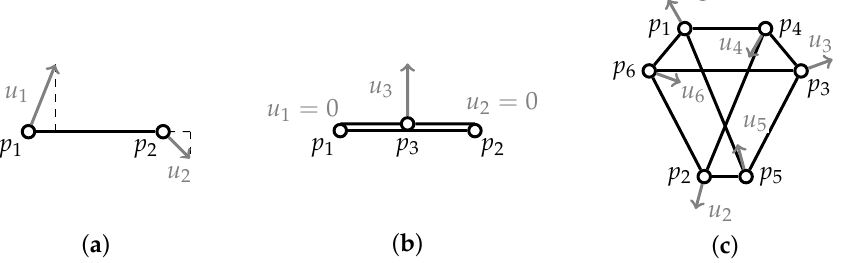
Figure 2. Velocity vectors of a trivial infinitesimal motion ( a ) and non-trivial infinitesimal motions ( b , c ) of frameworks in the